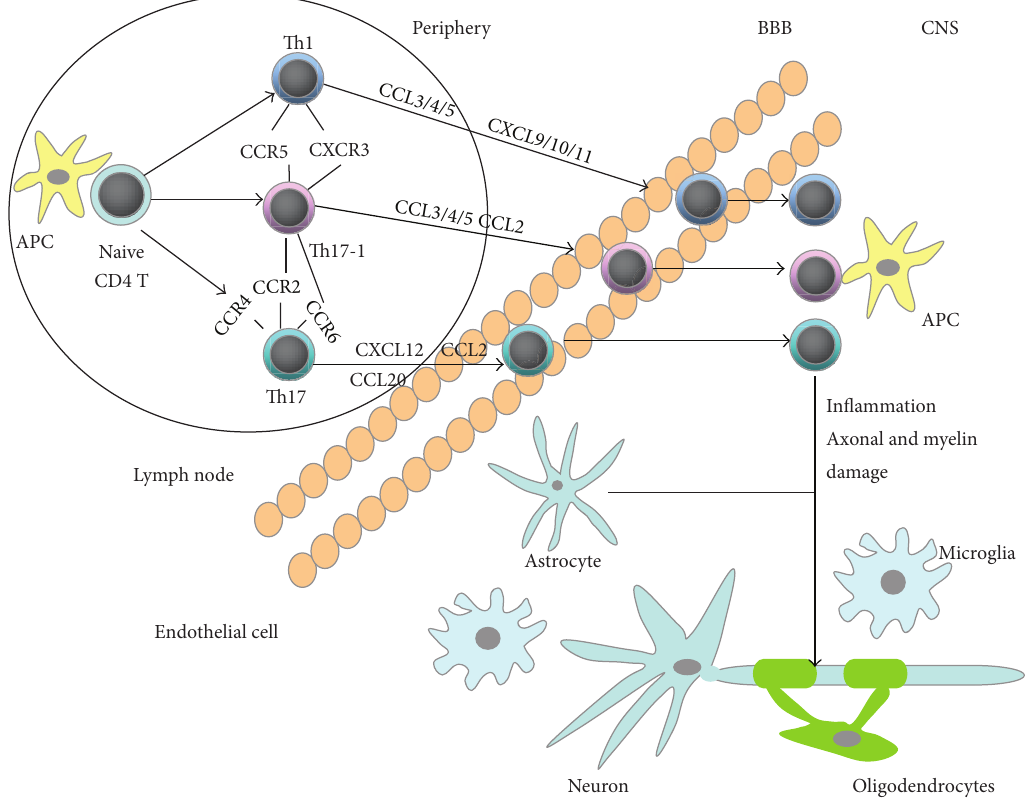
Figure 1: Migration and effector function of T cells in CNS during MS.